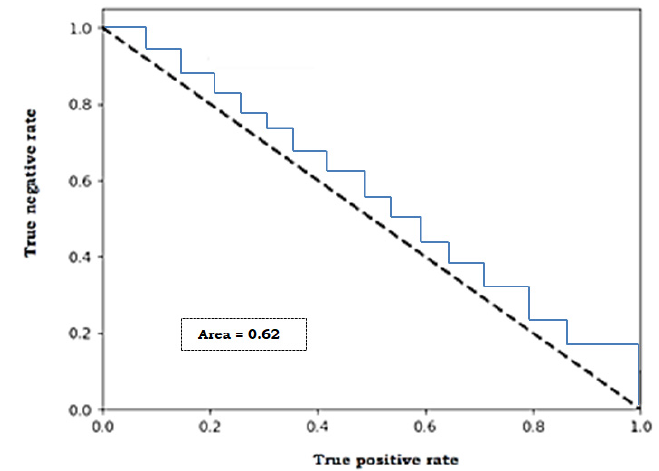
Figure 5. Receiver operating characteristic (ROC) curve for logistic regression.